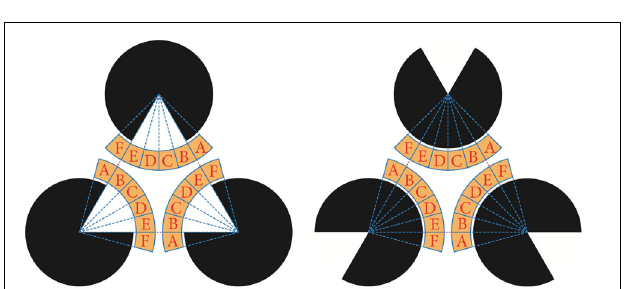
networks are shown in the image. Note that these networks are the results of individual trials and these photos are not in a time series.